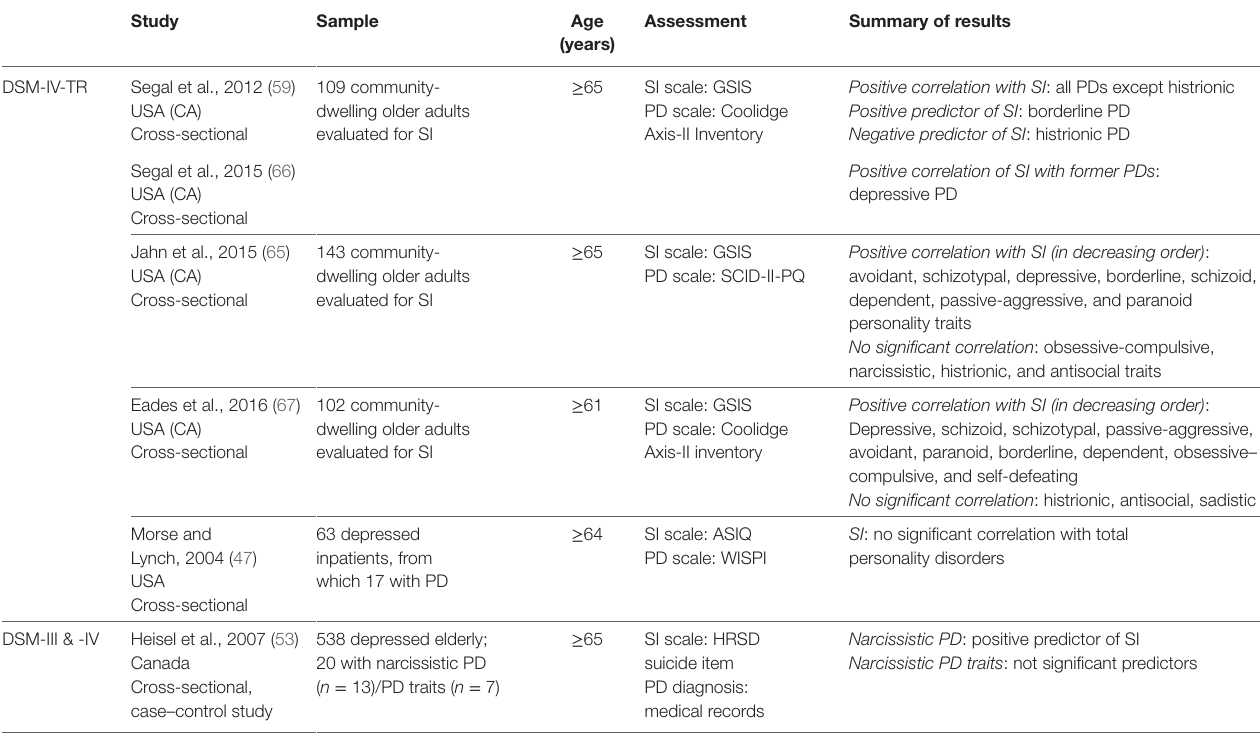
taBLe 3 | Categorical findings on suicidal